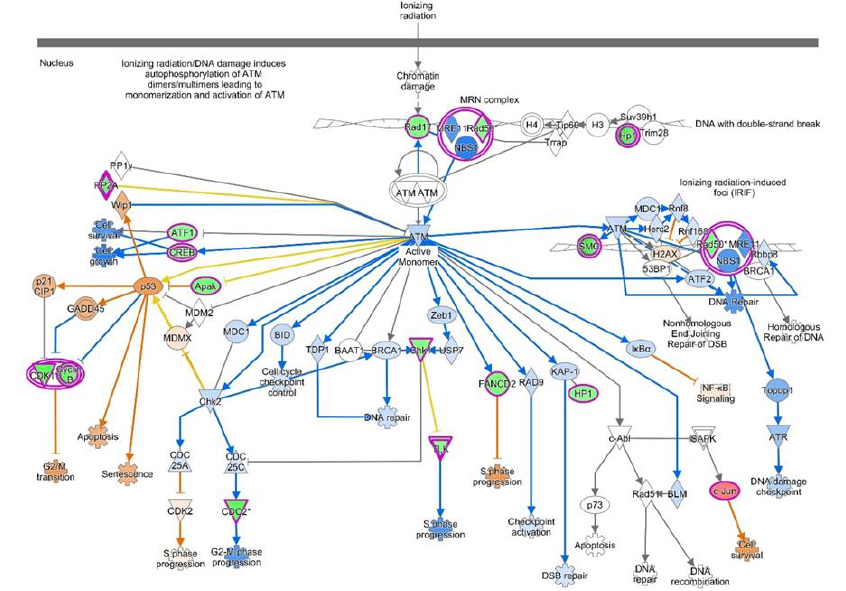
Figure 5. Activation of ATM signaling predicted by IPA-based pathway analysis. Pathway genes were overlaid to the DEGs, with upregulated ones shown in shades of red and downregulated ones shown in green.